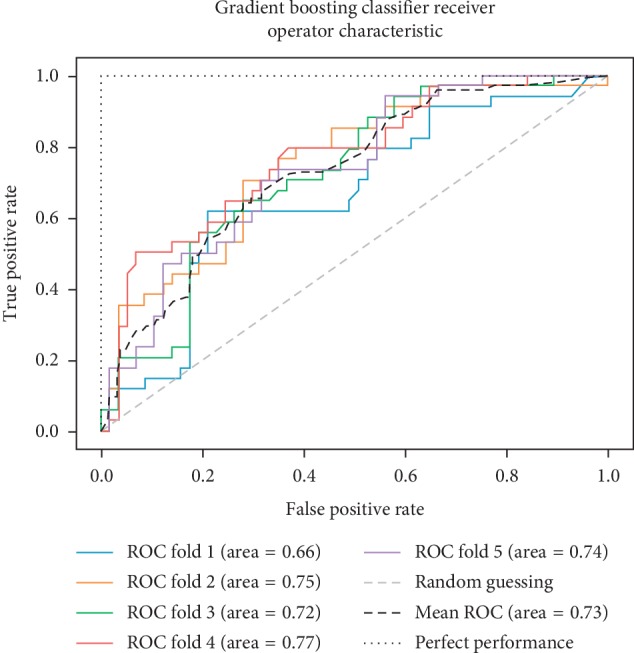
ROC curve for GB.